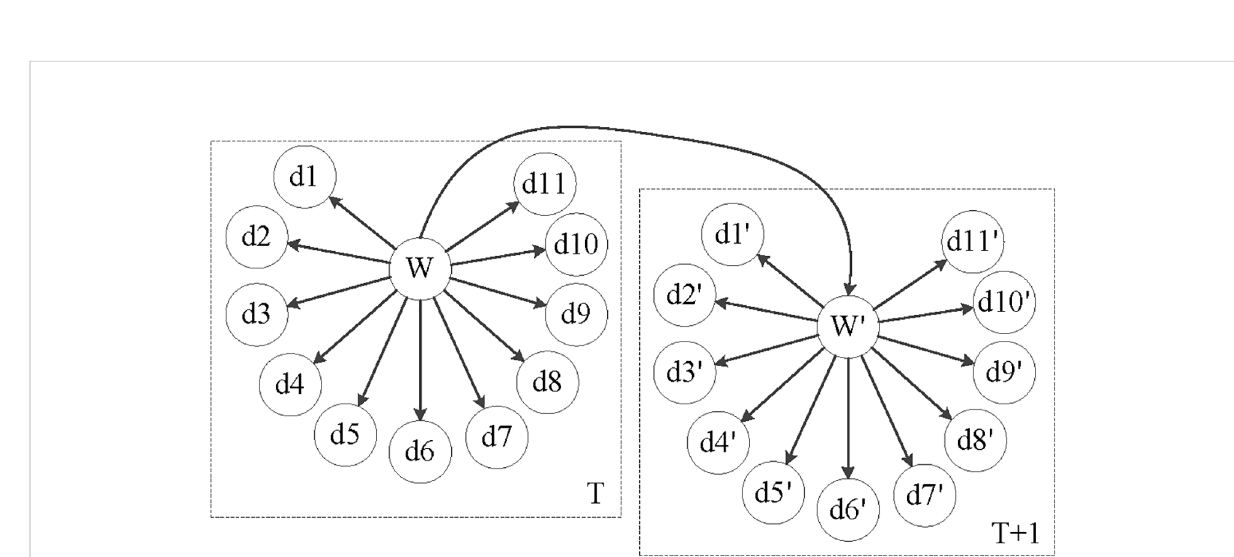
FIGURE 3 The DBN structure of UV navigation safety.